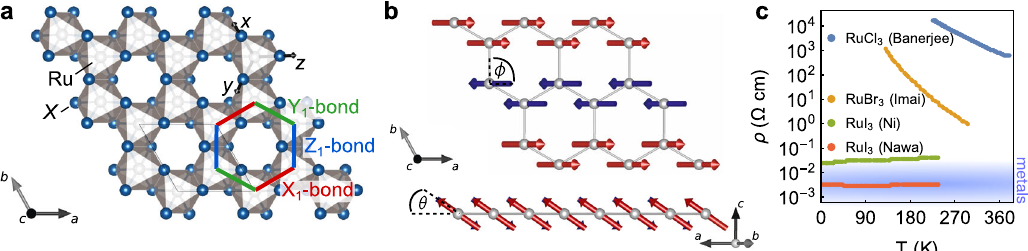
Fig. 1 RuX 3 (X = Cl, Br, I) crystal structure, magnetic structure, and resistivity. a Honeycomb layer in the RuX 3 (X = Cl, Br, I) trihalides with bond de fi nitions, cubic axes ( xyz ) and crystallographic axes ( abc ) in the R 3 structure, b Zigzag magnetic order in a honeycomb layer from two perspectives, with de fi nitions of in-plane-angle ϕ and out-of-plane-angle θ . c Comparison of experimental dc resistivities as a function of temperature. Data was extracted from plots in the following references and labeled by respective fi rst-author names: RuCl 310 , RuBr 325 , and RuI 326,27 . The shaded background depicts a typical range of resistivity for bad metals 28 . Table 1. Overview of reported speci fi c heat parameters.